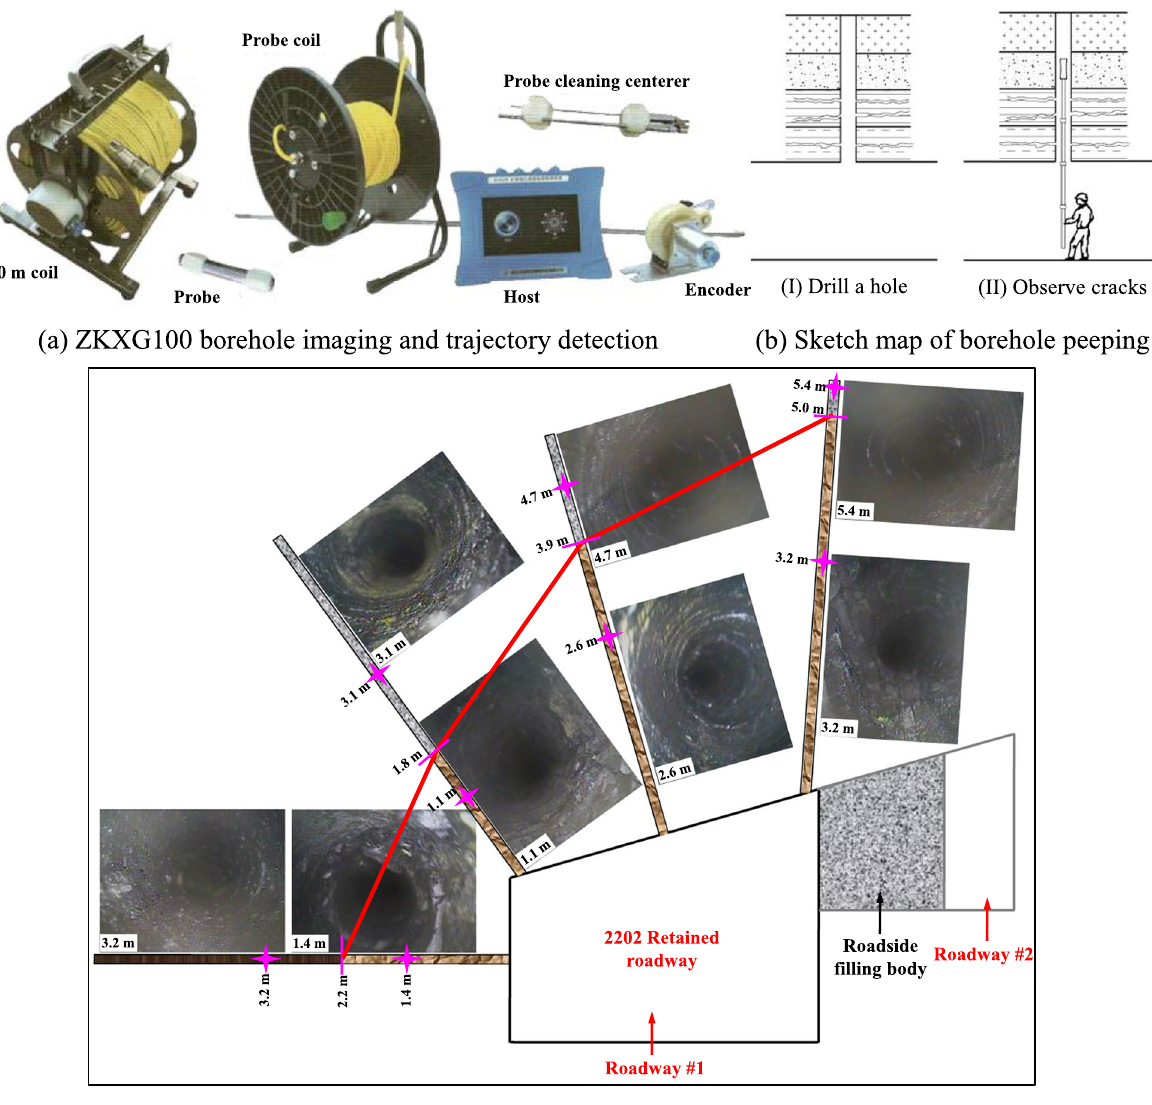
Fig. 14 Principles and results of drilling